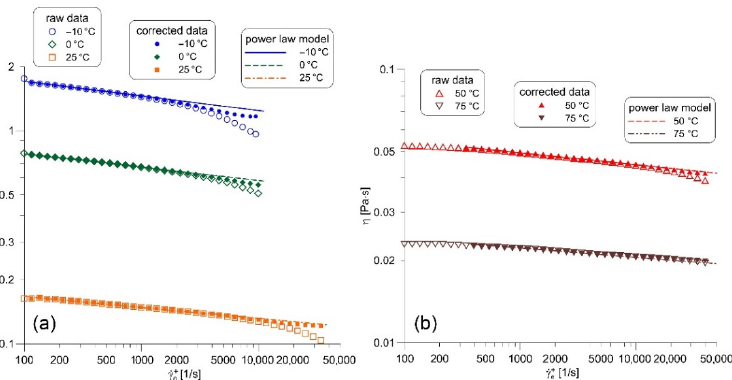
Figure 5. Temperature correction of the apparent viscosity of the base oil 10W40 at: ( a ) low cup temperatures; ( b ) high cup temperatures. MoS 2 nanoparticles and nanohybrid particles in the base oil 10W40. Figure 6 compares the corrected viscosity of the base oil without additives with the viscosity of the base oil with different types of MoS 2 additives. The nanohybrid suspension MoS 2 /CNTs demonstrates the lowest apparent viscosity in the entire range of shear rates at temperatures lower than and equal to 25 °C. The suspension of reference MoS 2 nanoparticles is the most viscous in the whole range of shear rates at the lowest temperature, − 10 °C. However, at higher tem- peratures, the suspension of synthesized MoS 2 nanoparticles exhibits the highest apparent viscosity in the region of low and medium shear rates ( 𝛾(cid:4662) (cid:3032)(cid:2878) < 3000 𝑠 (cid:2879)(cid:2869) ). In the highest shear rates region, the viscosity of the base oil and viscosities of all MoS 2 suspensions differ very little at temperatures higher than 25 °C. The lowest viscosity at 50 °C and in the region with the highest shear rates demonstrates the base oil without MoS 2 additives, but at 75 °C the nanohybrid suspension MoS 2 /CNTs has a slightly lower viscosity. One should also note that all nanohybrid suspensions exhibit considerable deviations of the apparent vis- cosity from the primary trend in the region of low and medium shear rates at 50 °C and 75 °C. These deviations can be attributed to the inhomogeneous geometry of the sus- pended particles of nanohybrid suspension contained in the MoS 2 /CNTs samples, as sug- gested by Bojarska et al. [10]. The lack of homogeneity in the shape of the particles could result in their migration in the Couette flow and in this way affect the measured torque.